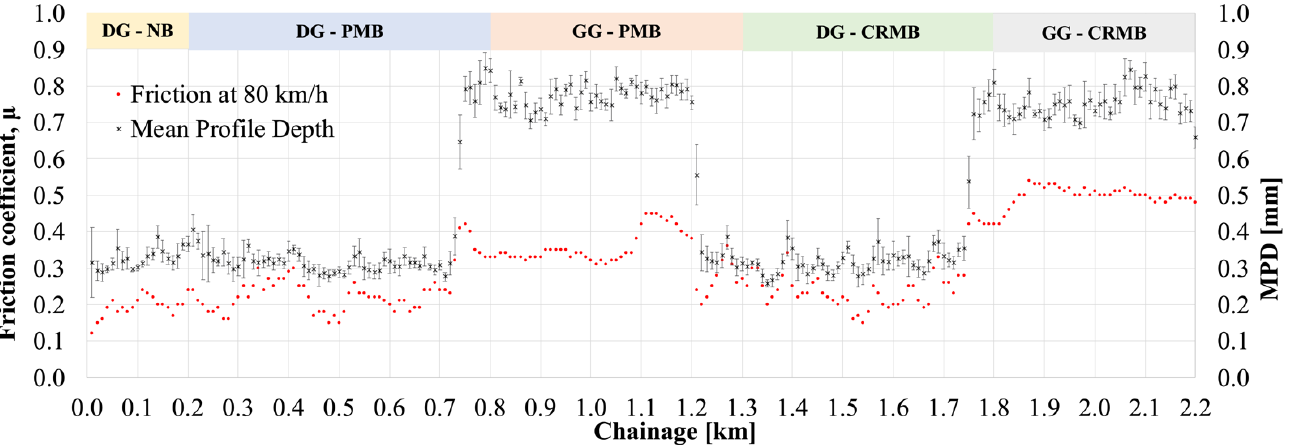
Figure 10. Mean Profile Depth and Friction Coefficients for the Various Sections.